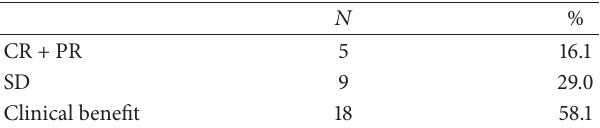
Table 3: Best response of the metronomic combination of VRB and CAPE according to RECIST criteria. 𝑁 = 31